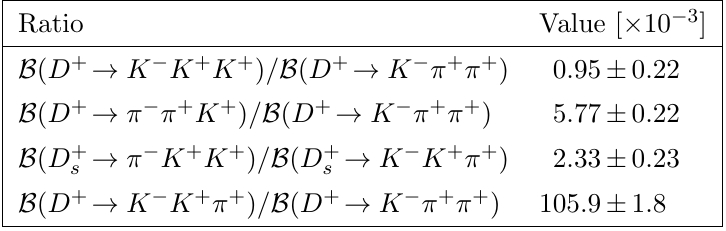
Figure 1 . Feynman diagrams for the DCS decays (a) D + ! K (cid:0) K + K + , (b) D + ! (cid:25) (cid:0) (cid:25) + K + and (c) D + ! (cid:25) (cid:0) K + K + . s